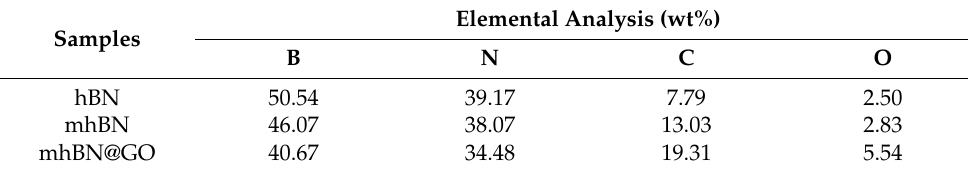
Figure 3. XPS spectra and decomposed C 1s spectra of ( a ) hBN, ( b ) mhBN, and ( c ) mhBN@GO. Table 1. Chemical element compositions of hBN, mhBN, and mhBN@GO.